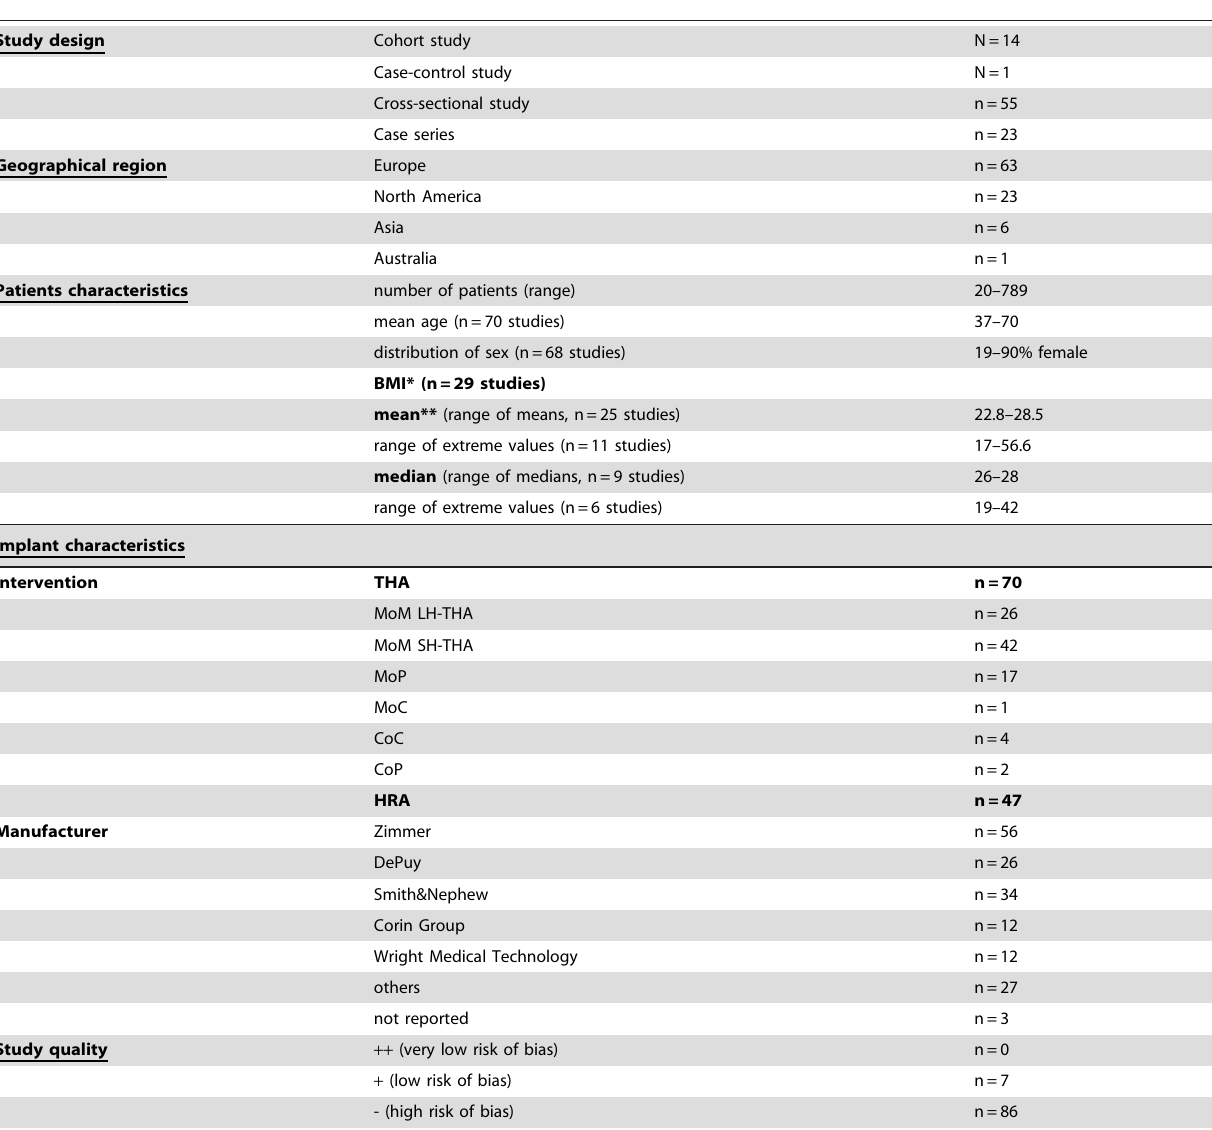
Table 5. Summary of study characteristics of included epidemiological studies.